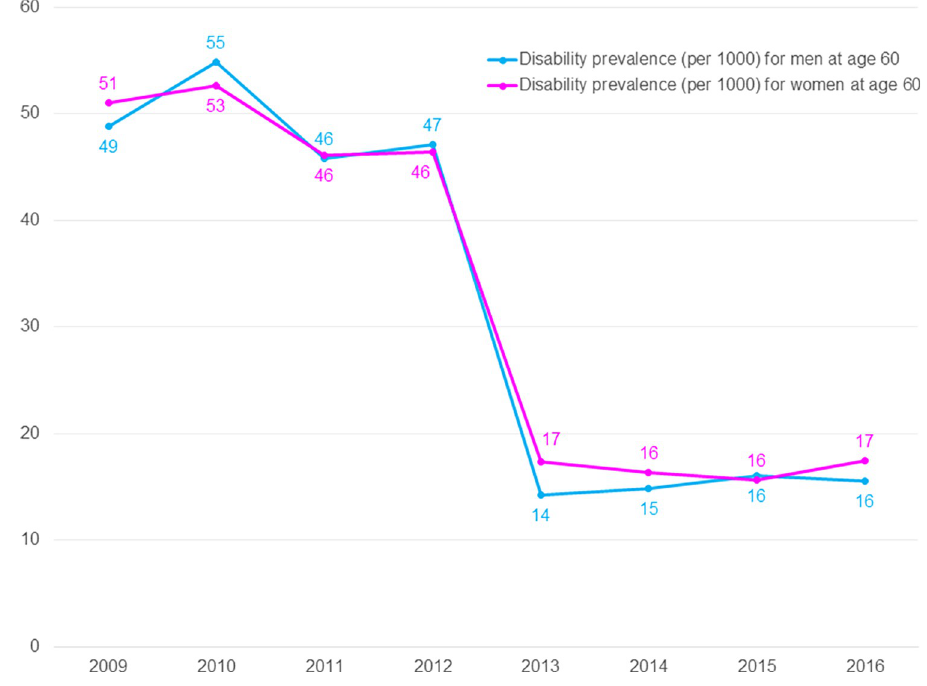
Fig 1. Disability prevalence (per 1000) by gender at age 60 from 2009 to